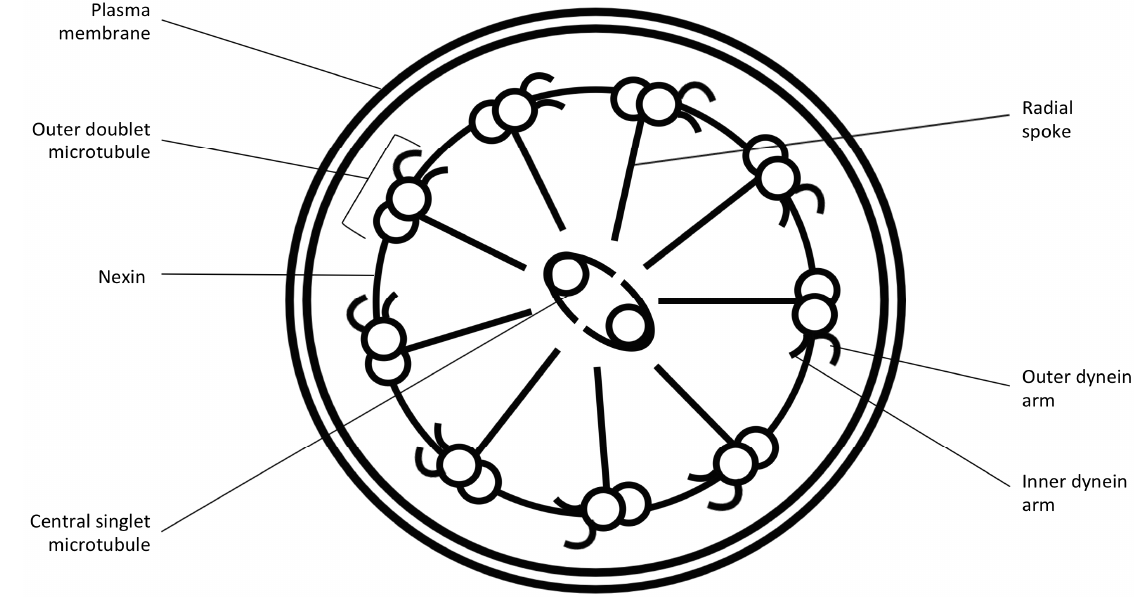
Figure 1. Diagram showing the main structural elements of the human motile cilium with the “9 + 2” arrangement.